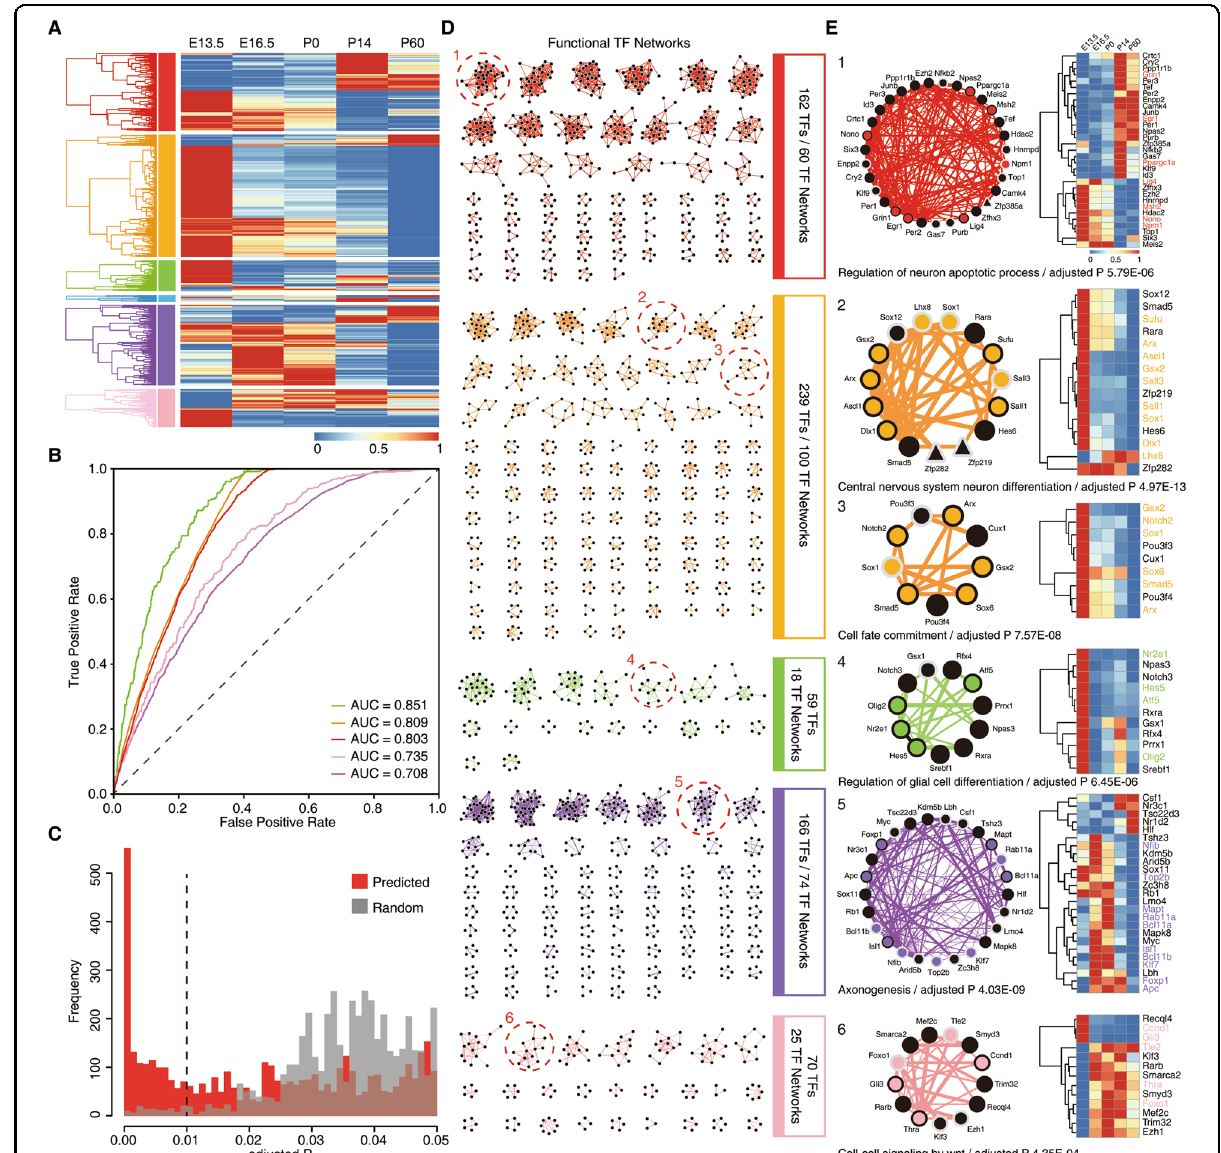
Fig. 4 Predicted potential functional TF networks based on machine learning. A Expression patterns of 740 differentially expressed continuous TFs from different co-expression modules. B Receiver operating characteristic of differentially expressed continuous TFs from each co-expression module. The AUC is used to assess the quality of machine learning. The AUC of the diagonal is 0.5. C Functional signi fi cance distribution of predicted TF networks and random TF networks. D Schematic of the global atlas of inferred functional TF networks in striatal development. E Example of TF networks with different functions of known and unknown subunits. The width of the edges increases with the increase of correlation score. The shape of the node represents whether it is a homologous TF to human (circular node for homology to humans, triangle node for unique in mouse). The color of the node border represents whether the TFs are associated with nervous system disease (black border for disease TFs, gray border for non-disease TFs). The black node indicates potential functional TFs. Expression patterns of representative TF networks are shown on the right by